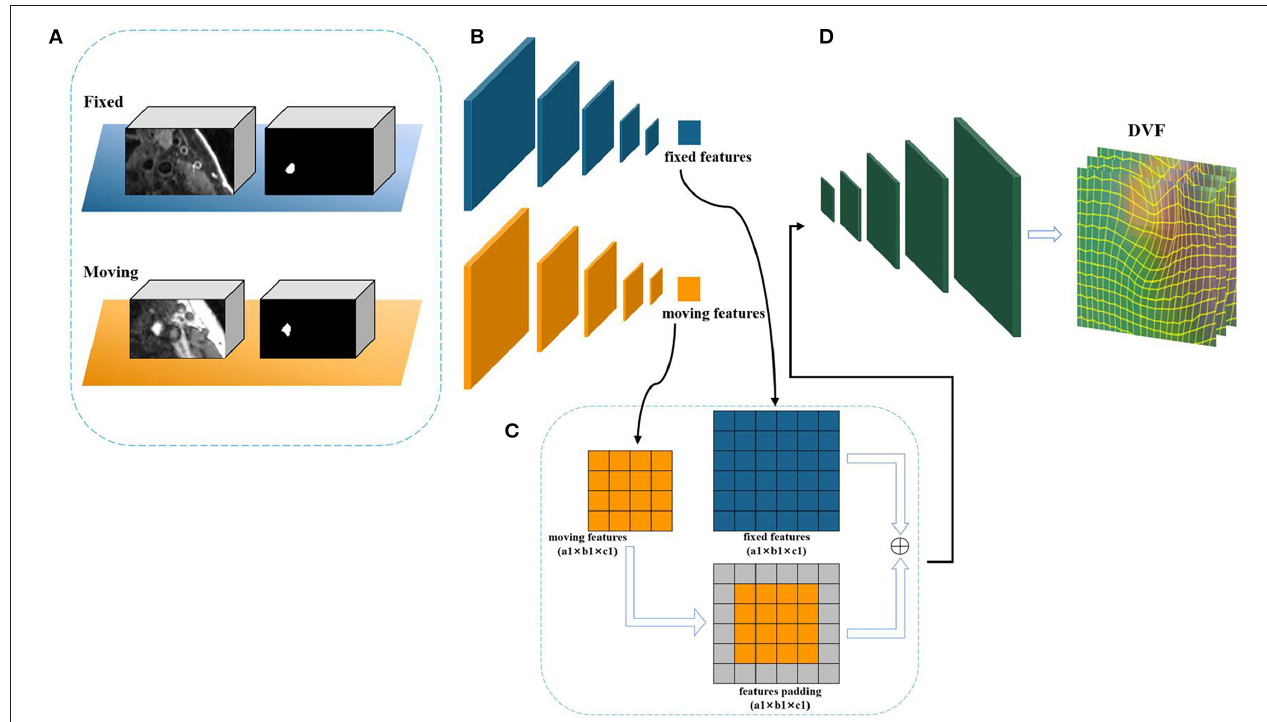
FIGURE 4 | The framework of cross-scale Siamese U-Net. (A) The inputs of Siamese U-Net containing an image pair and a label pair. (B) The feature extraction sub-network of down sampling. (C) The padding module. (D) The up-sampling structure to restore the feature size of deformable displacement field.